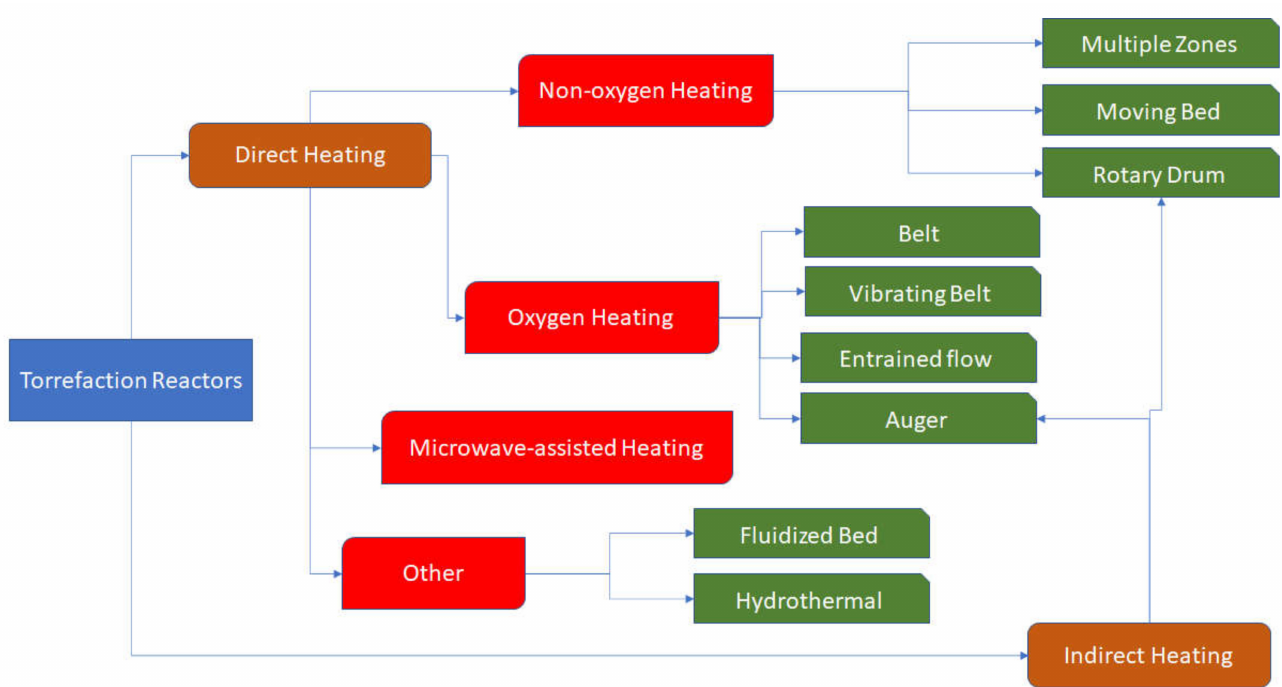
Figure 2. Torrefaction reactors